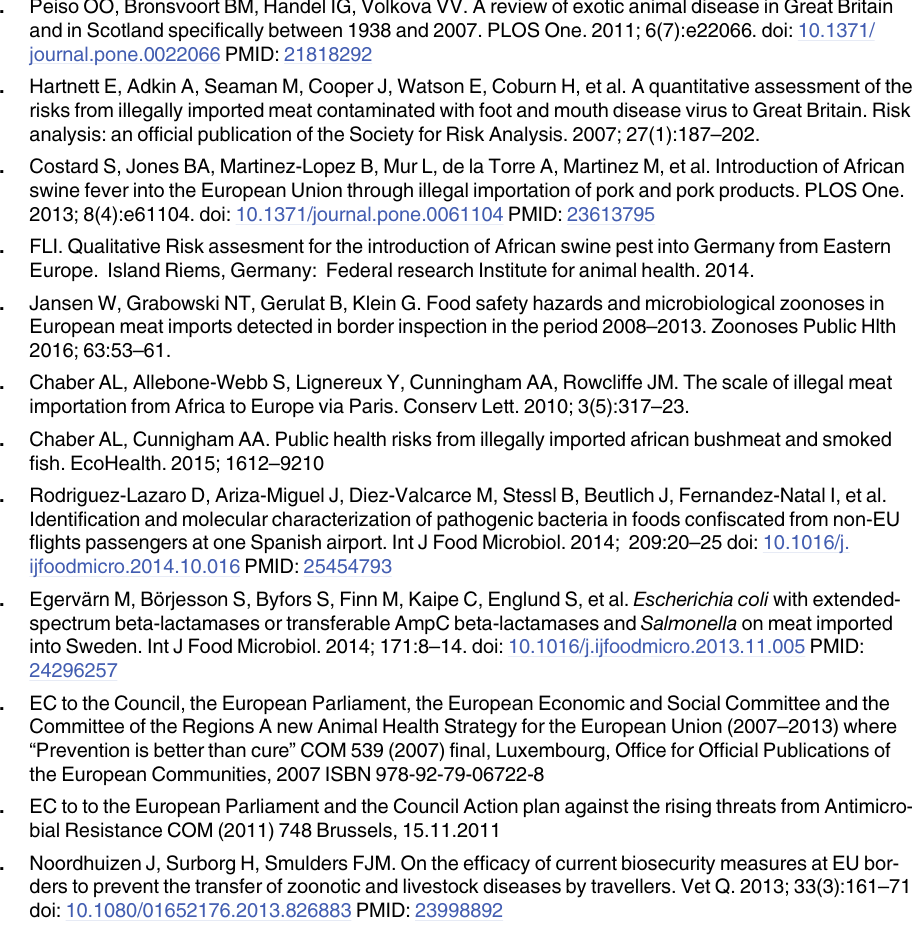
S1 Fig. Interactive version (chorddiagram) of Fig 5 with seized meat products, dairy prod- ucts, and other POAO in kilogrammes at IA 2 in 2014 according to region of origin. Arc lengths on the outer circle are proportional to the fractions of POAO categories and regions of origin,